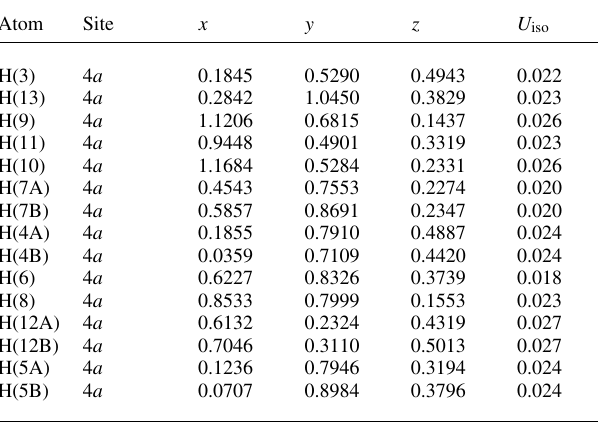
Table 2. Atomic coordinates and displacement parameters (in Å 2 )